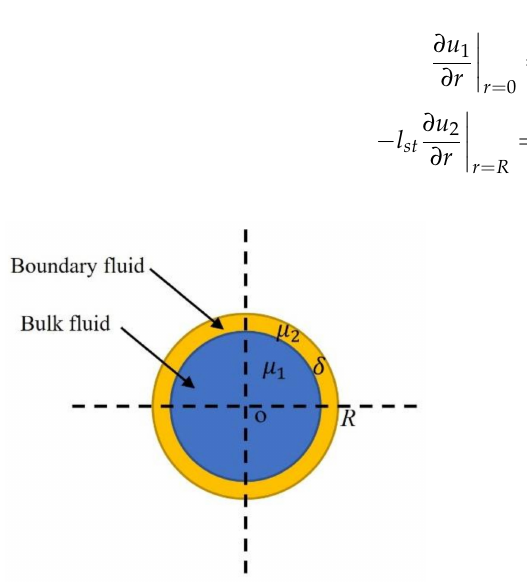
Figure 16. The two fluid